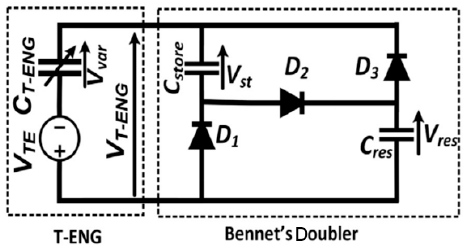
Figure 3. Bennet’s doubler circuit diagram.